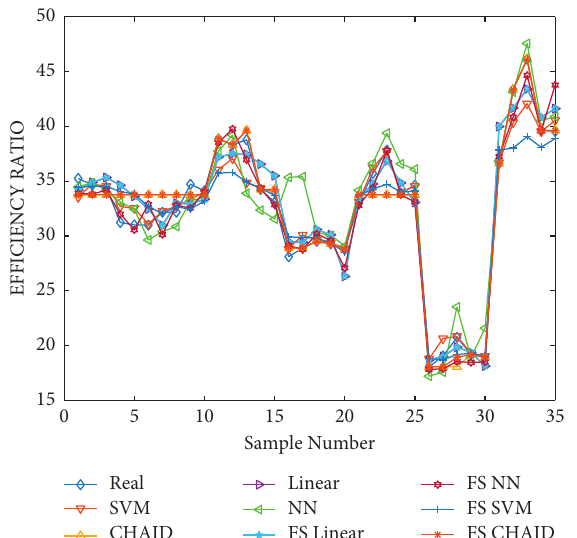
Figure 4: Overall relationship (training and testing data set) between the real and the predicted efficiency ratios with and without feature selection